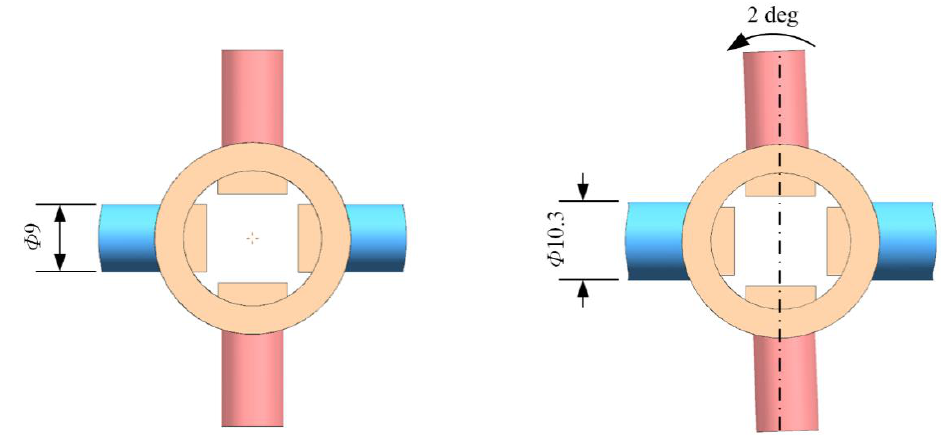
Figure 18. The comparison of two mechanical structures before and after improved geometry.